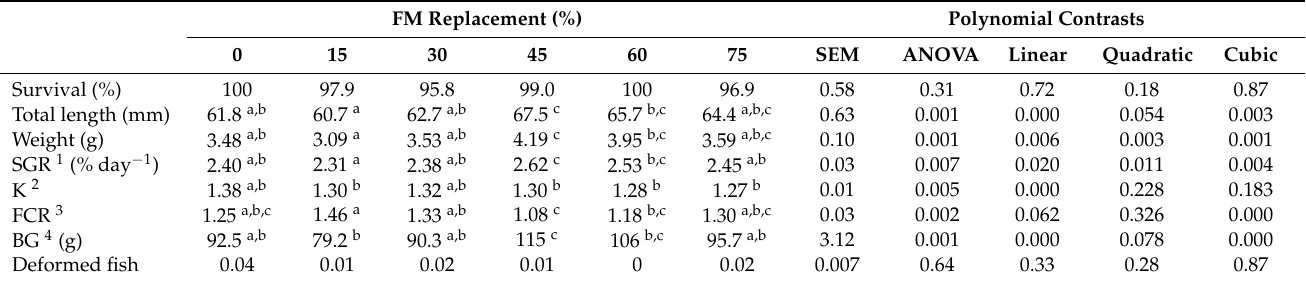
Table 5. Survival, growth performance, and percentages of juvenile tench with externally visible deformities fed practical diets with different levels of substitution of fishmeal (FM) by black soldier fly larvae meal (BSFLM) over 90 days.